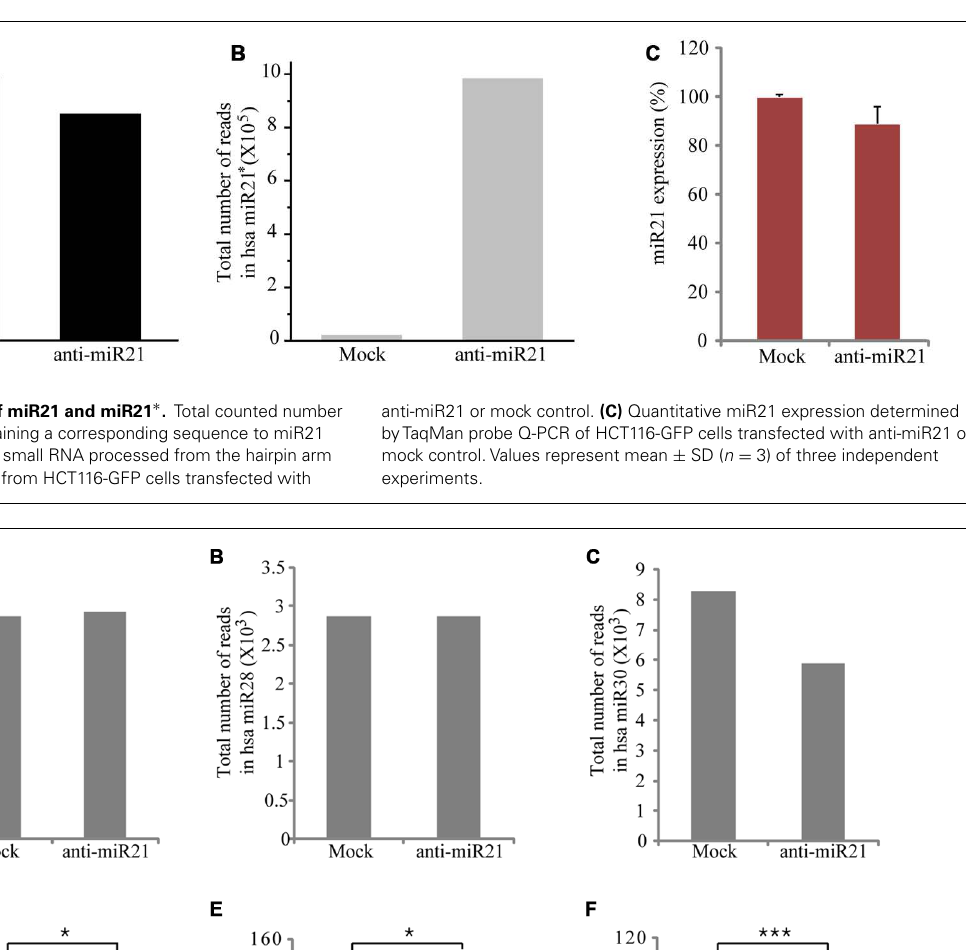
FIGURE 3 | Regulation of miRNA expression by anti-miR21 in CRC. Expression levels of miRNAs that had the highest counts in HCT116 deep-sequencing results. Total number of RNA sequence reads for miR20 (A) , miR28 (B) , and miR30 (C) in HCT116-GFP cells transfected